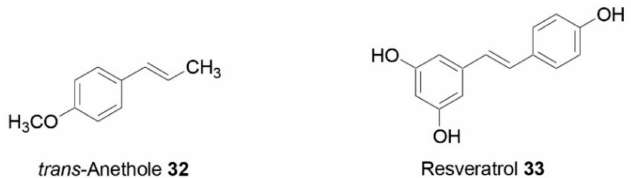
Figure 4. Phytochemical compounds acting by brown adipose tissue activation